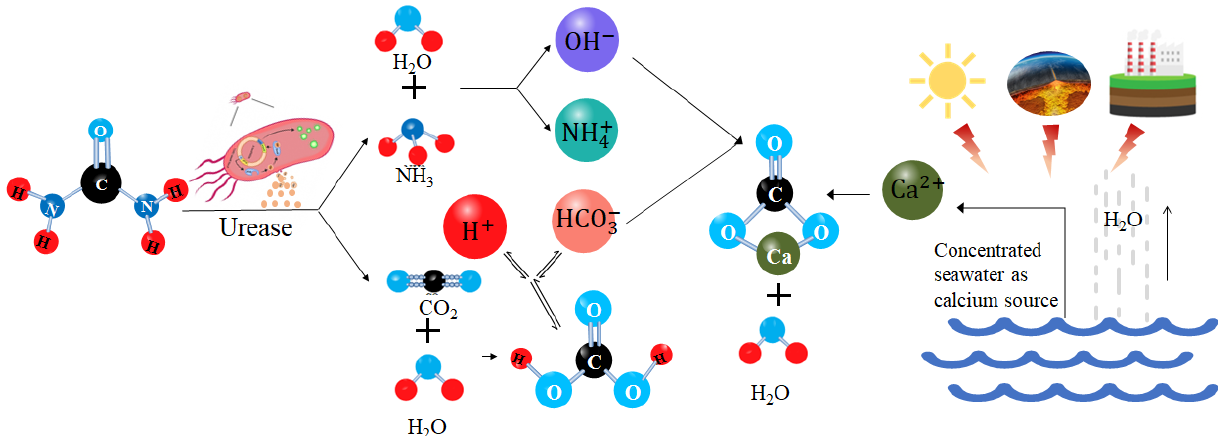
Figure 1. Principle of MICP.